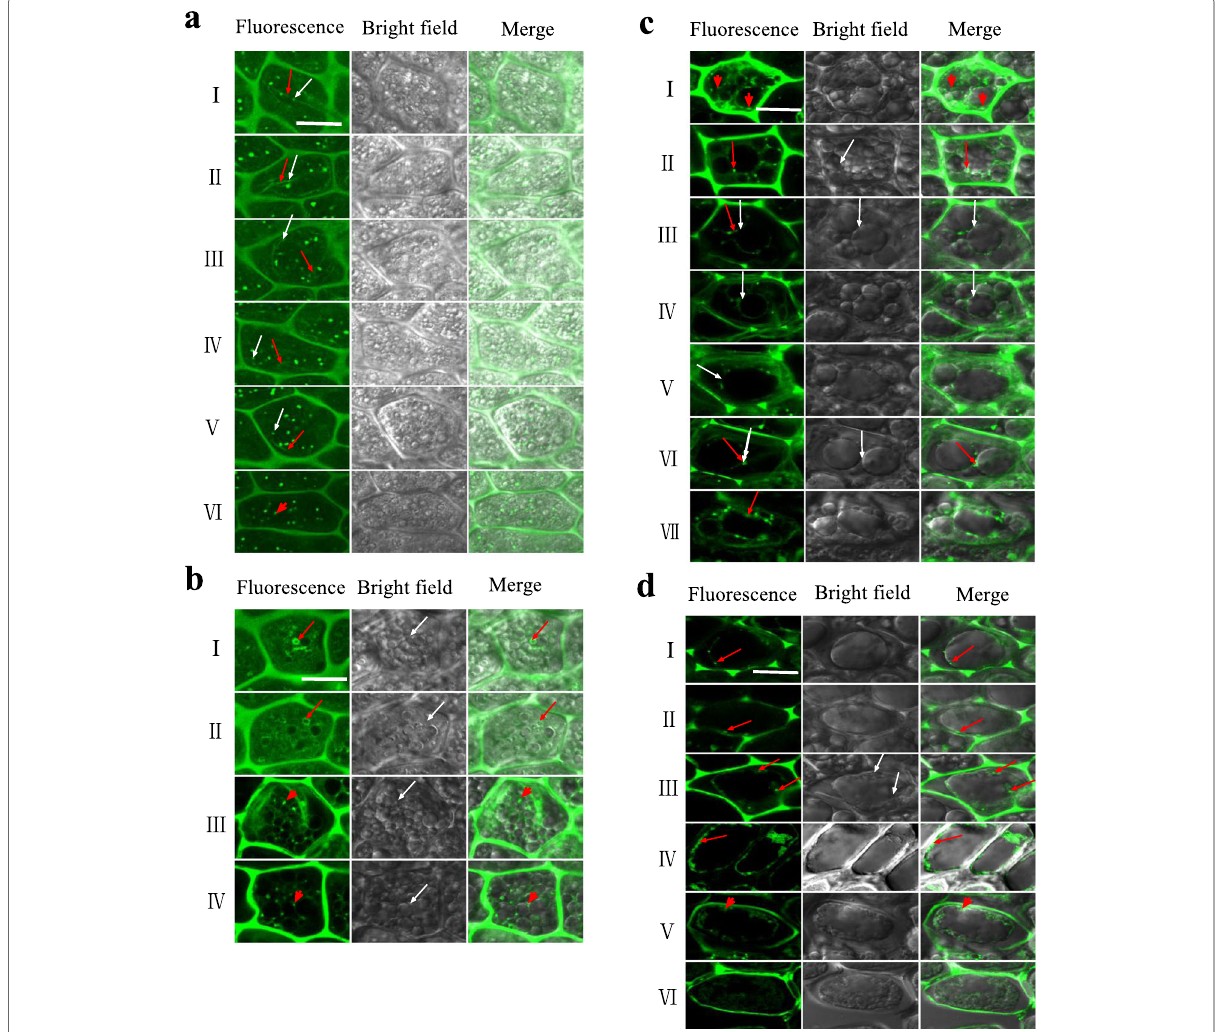
Fig. 5 The changes of AF structure influenced vacuolar morphology. Aleurone layers were stripped from the intact seeds imbibed for 12 h, and then the isolated layers were pre-incubated in distilled water alone from 1 d to 7 d, the incubated layers were labeled with FITC-phalloidin, the organization of AF (green) was observed by LSCM, and images were immediately captured. The experiments were repeated three times, and similar images were obtained. Scale bar is 10 μ m. a The tiny vacuoles and the morphological changes of AFs. b The small vacuoles and the morphological changes of AFs. c The larger vacuoles and the morphological changes of AFs. d The large central vacuoles, the shrinking protoplast and the morphological changes of AFs